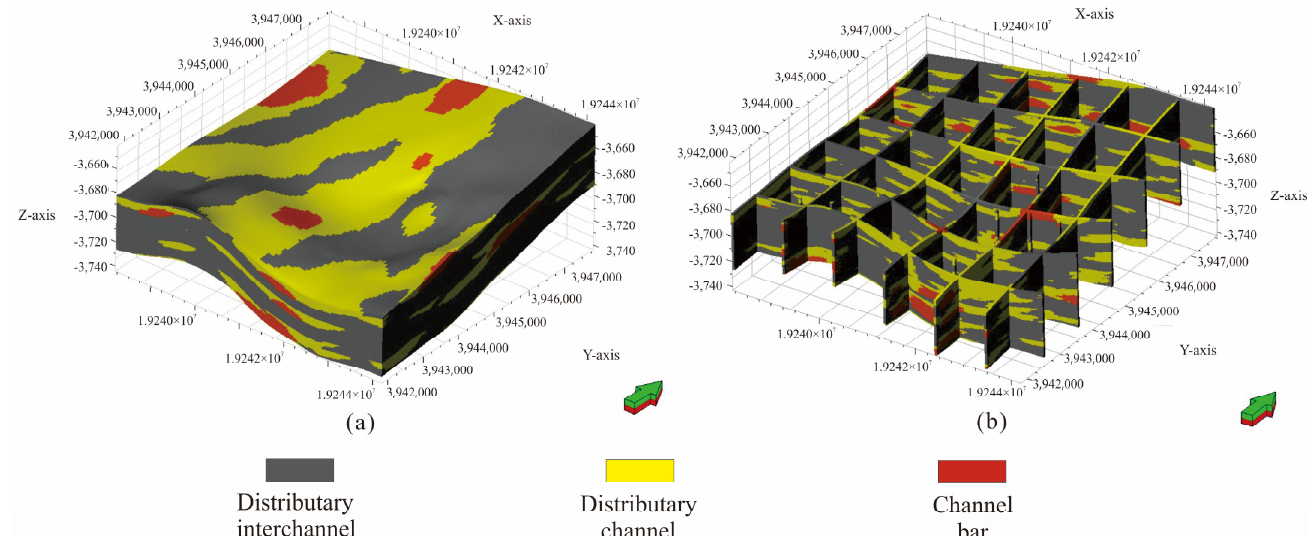
Figure 10. Simulation result of MPS based on 2D TIs. ( a ) 3D model; ( b ) grid model.